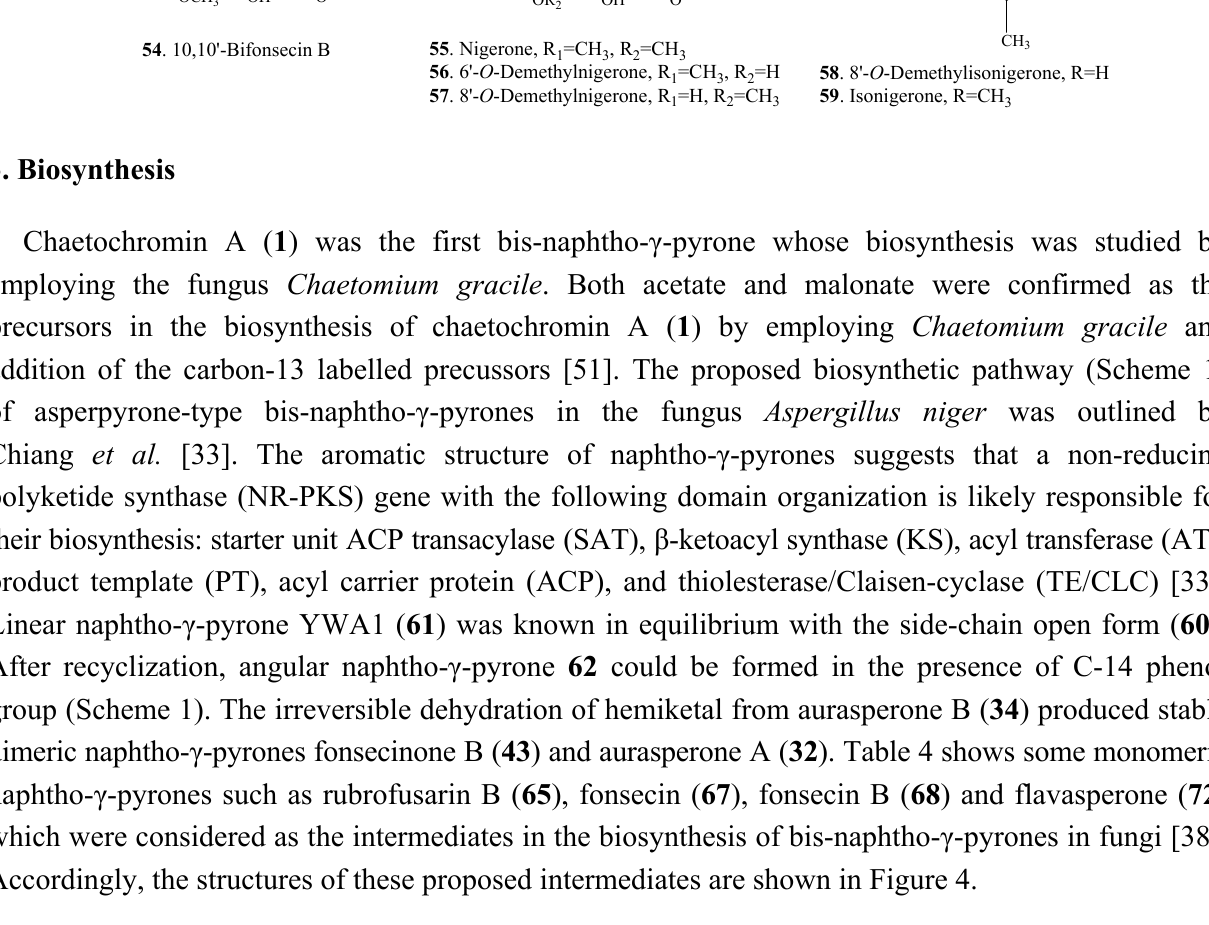
Table 4. Some monomeric naphtho- γ -pyrones 63 – 76 from